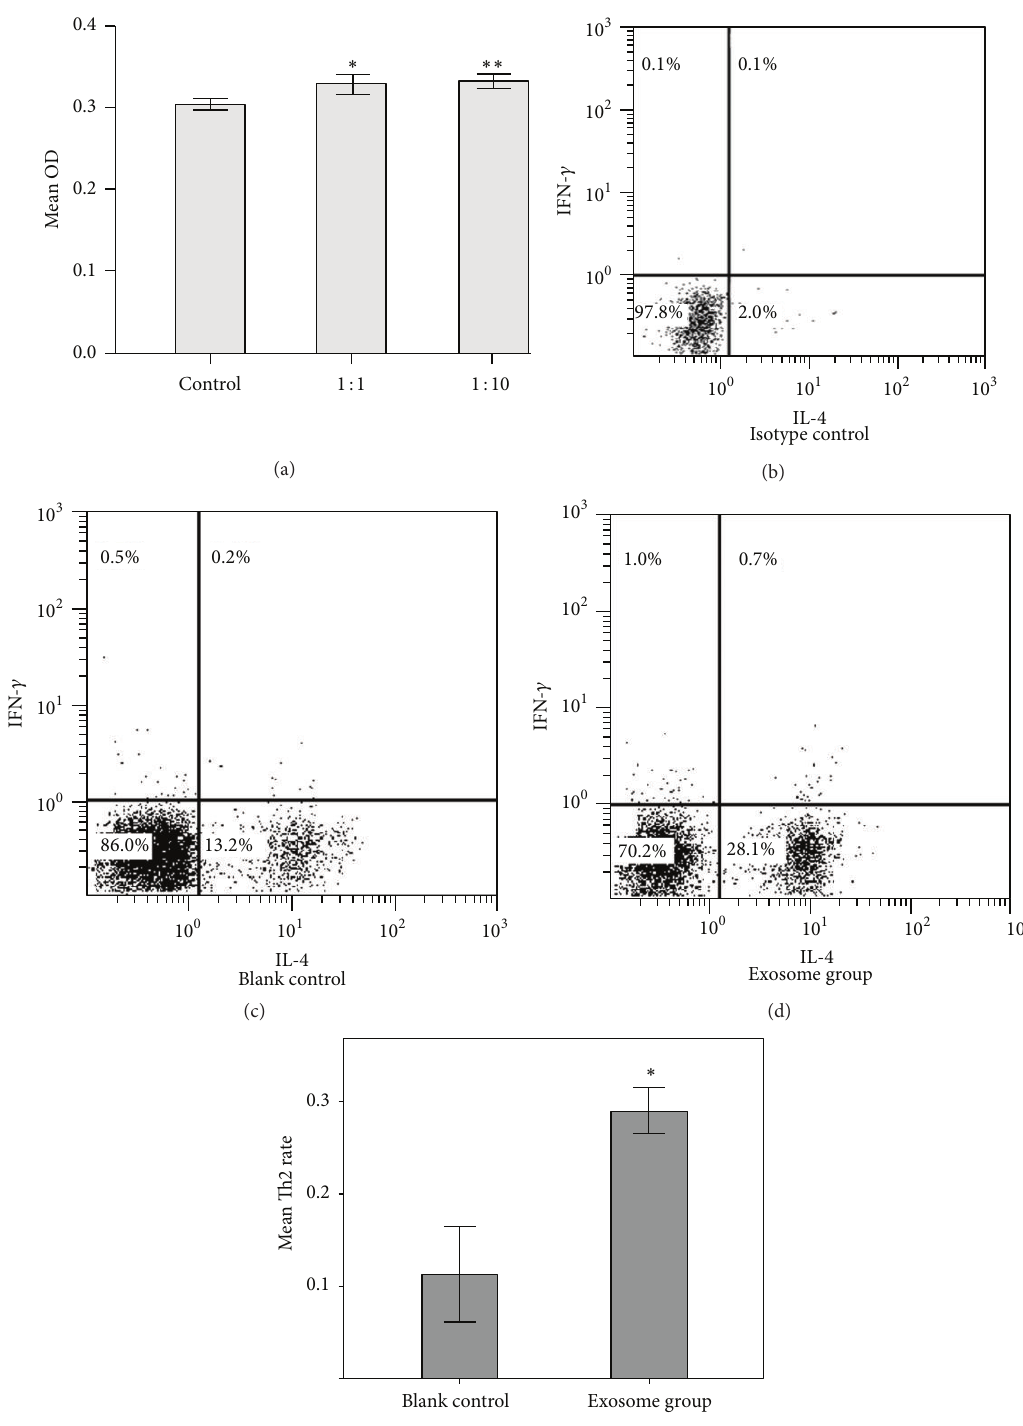
Figure 3: Effects of BMMC-exosomes on naive CD4 + T cells. (a) 10 6 naive CD4 + T cells were coincubated with BMMC-exosomes generating 10 6 or 10 7 BMMCs under Th2 conditions. Compared with the blank control without exosomes, groups containing different levels of exosomes showed higher proliferation. T cell proliferation was quantified by incorporation of CCK-8. Results are expressed as mean O.D. at 450 nm and are representative of three experiments. ∗ , compared with control, 𝑝 < 0.05 . ∗∗ , compared with 1:1 group, 𝑝 > 0.05 . Student-Newman-Keuls (SNK) test was used. (b–d) After 72 h of culturing, the exosome group showed over 28% of Th2 cells, which was about twice the control group. (e) The rate of Th2 cells in the T cells was expressed as mean ± SD ∗ , compared with blank control, 𝑝 < 0.05 . The results represented four independent